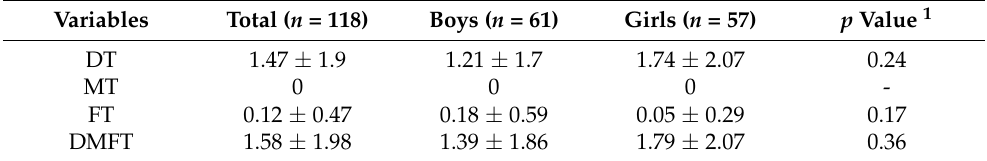
Table 1. Caries intensity expressed by the DMFT index with DT, MT and FT components in the 12-year-olds according to gender (mean values ± standard deviations). Variables